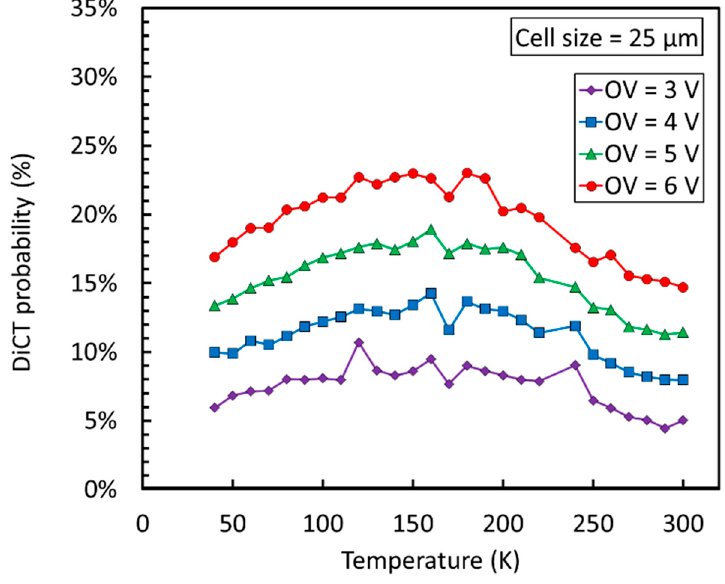
Figure 17. DiCT as a function of the temperature and overvoltage for NUV-HD-LF SiPMs. Measures taken from Reference [36].